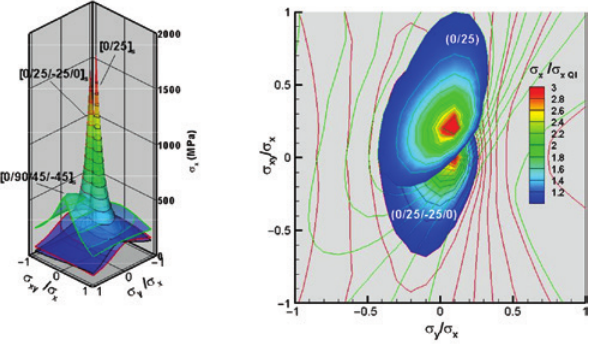
Figure 6: Comparison of Tsai-Wu failure surfaces for laminates of QI: (0/45/90/− 45), (0/ ± 25/0), and (0/25) stacks.